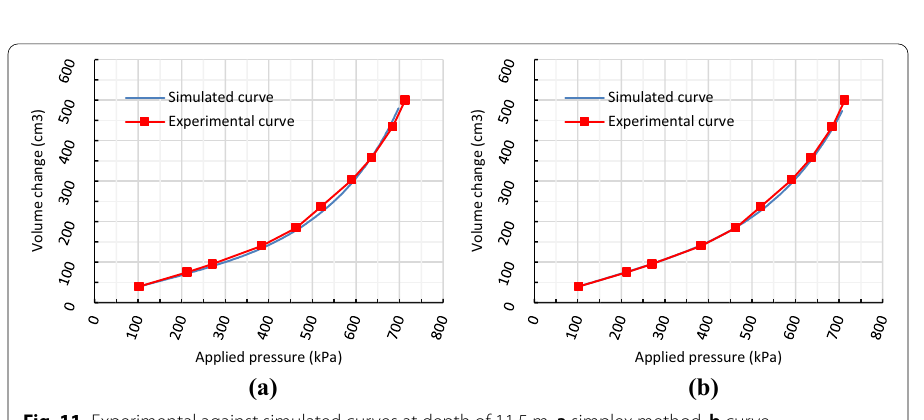
Fig. 11 Experimental against simulated curves at depth of 11.5 m, a simplex method, b curve decomposition method